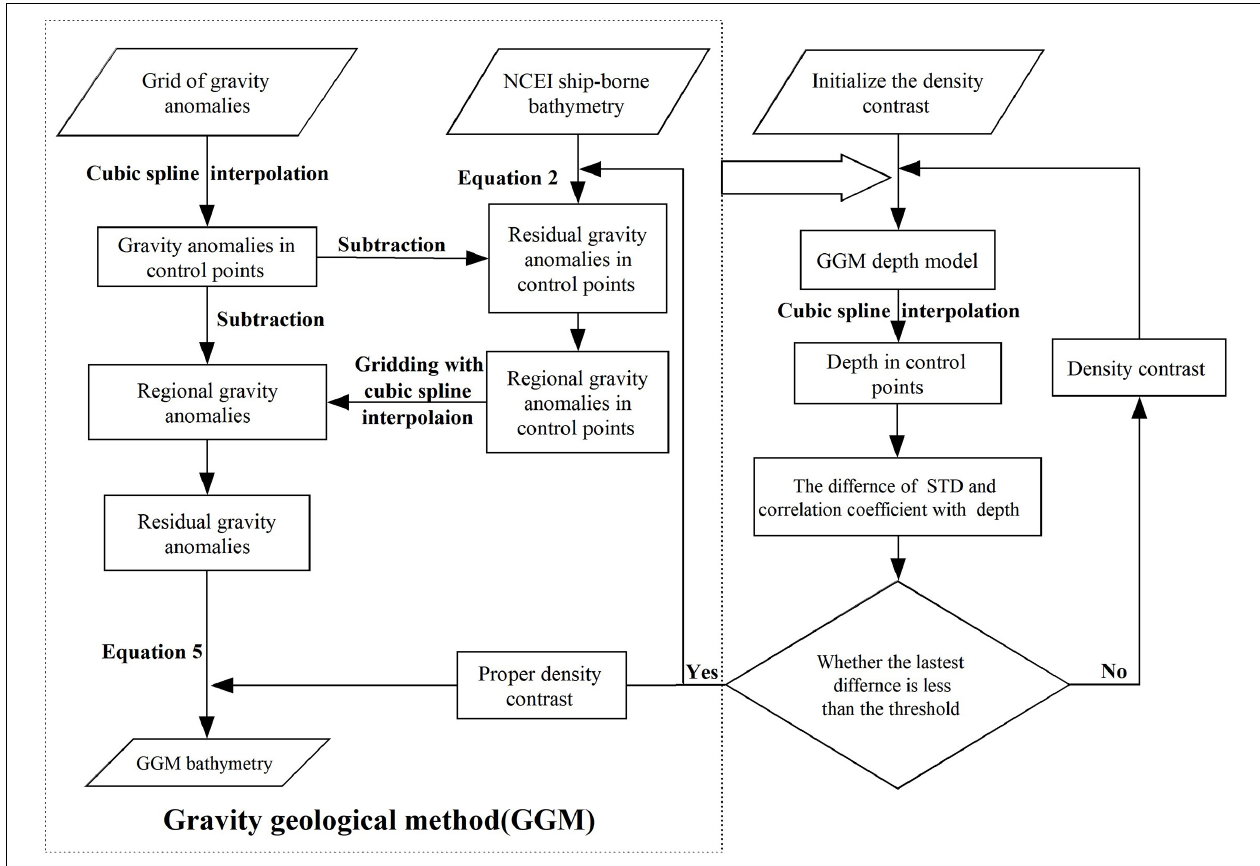
FIGURE 1 | Flow chart of the gravity-geologic method (GGM) and iterative